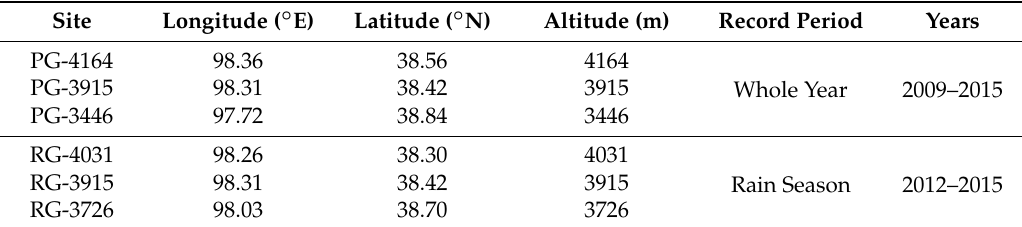
Table 1. Details of geographical coordinates and precipitation data for observation sites in the field.